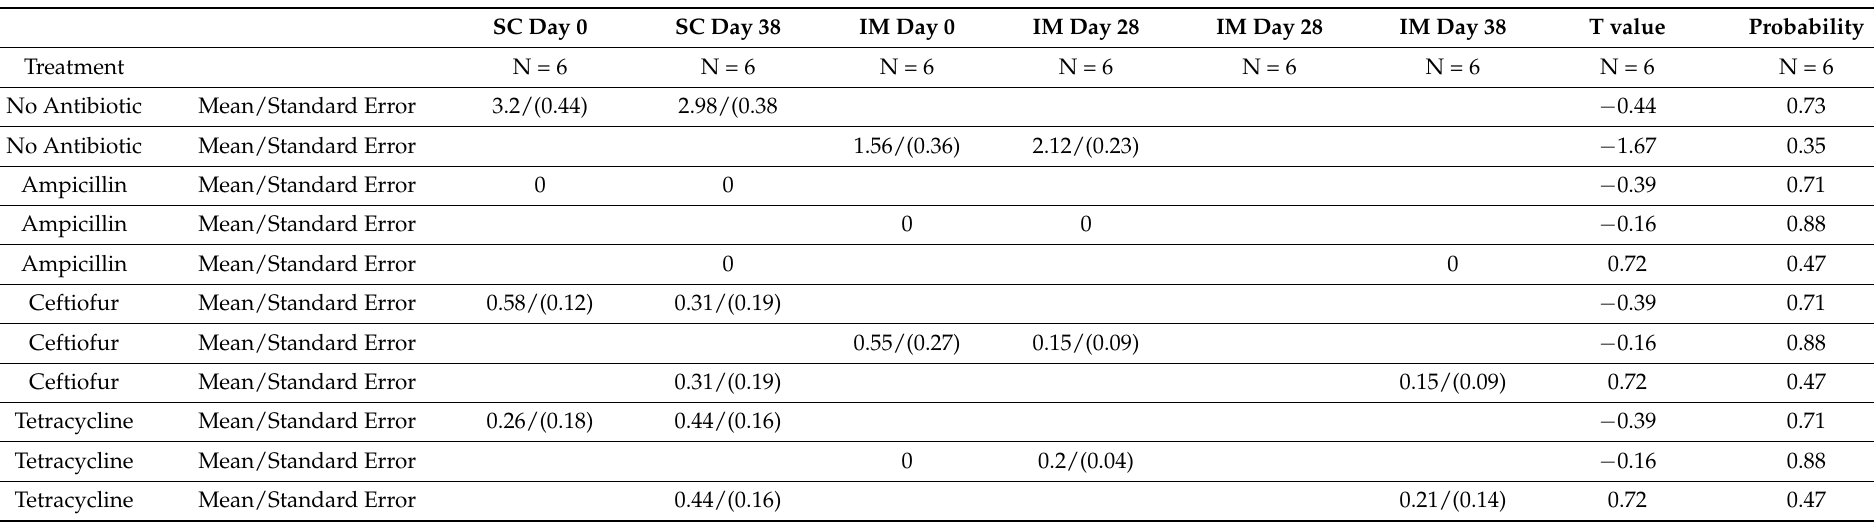
Table 5. Predetermined Student’s T tests to observe significant differences at particular time points for Enterococcus isolates grown with or without antibiotics. There were no significant differences noted for any of the above